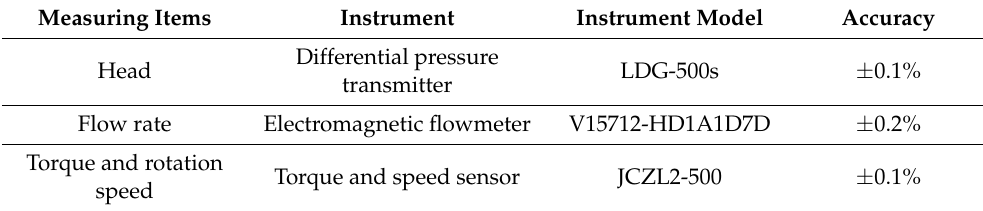
Table 3. Main test instruments of test bench.